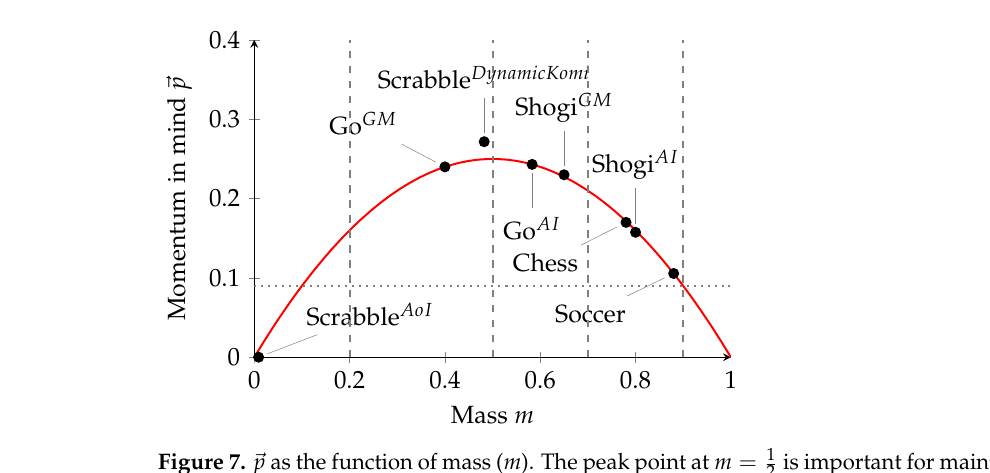
Figure 7. (cid:126) p as the function of mass ( m ). The peak point at m = 1 in games where the scoring turnover frequency of a game is the